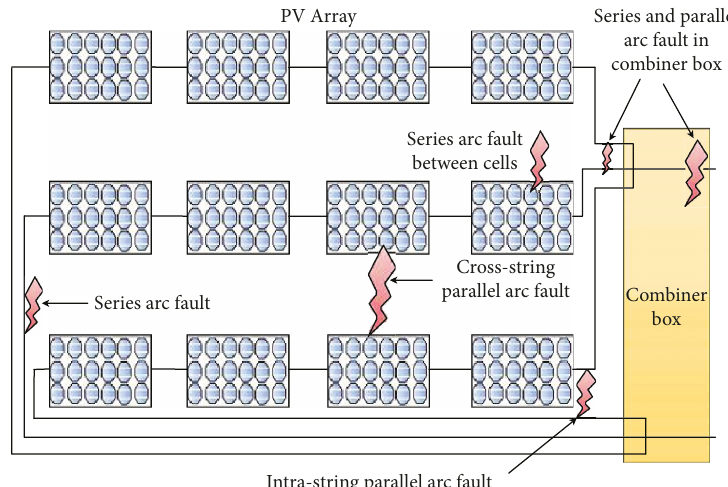
Figure 4: Possible locations of AFs in a PV array.